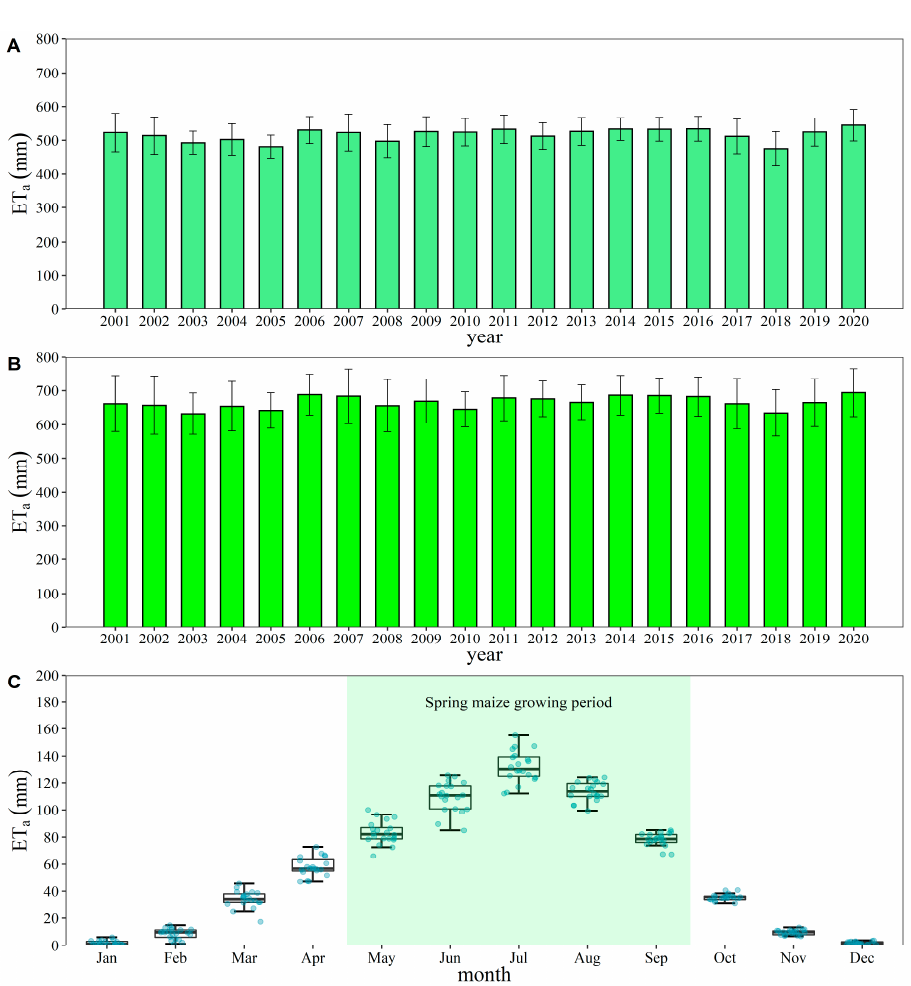
Figure 11. Temporal distribution pattern of ET a of spring maize in Jilin Province from 2001 to 2020. ( A ) Cumulative ET a during the spring maize growing periods for all years (1 May to 30 September); ( B ) cumulative ET a throughout the year in the spring maize growing area for all years (1 January to 31 December); ( C ) monthly distribution of ET a over the spring maize growing area for 20 years, where the shaded part represents the spring maize growing period. Data are presented as mean plus or minus standard deviation.